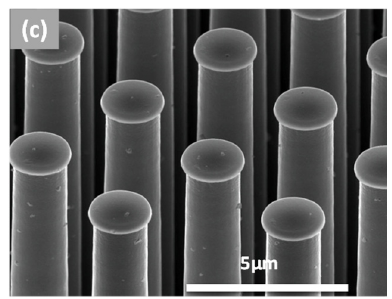
Figure 1. ( a ) Cross ‐ section, ( b ) top and ( c ) tilted view SEM images for TiN coated silicon pillar arrays.